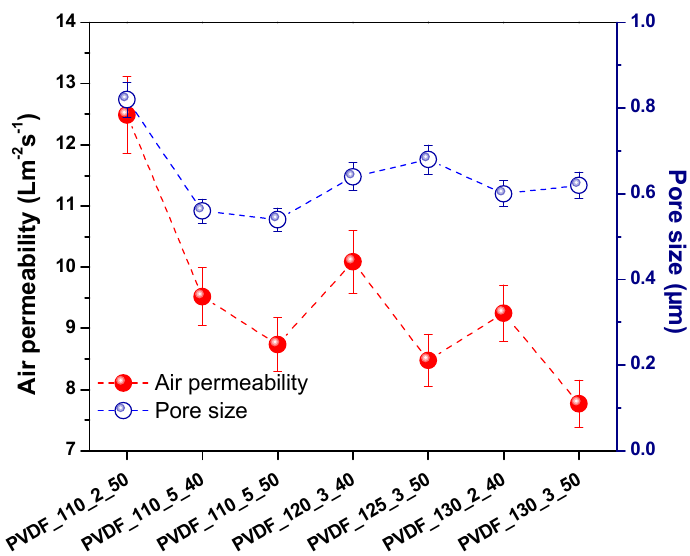
Figure 9. Pore size vs. air permeability of the nanofibrous membranes.